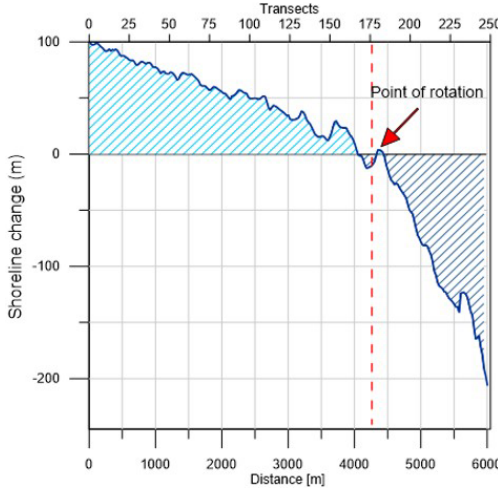
Figure 6. Shoreline changes between 1992 and 2013 at Cell I. (Note that light area is accretion and dark area is